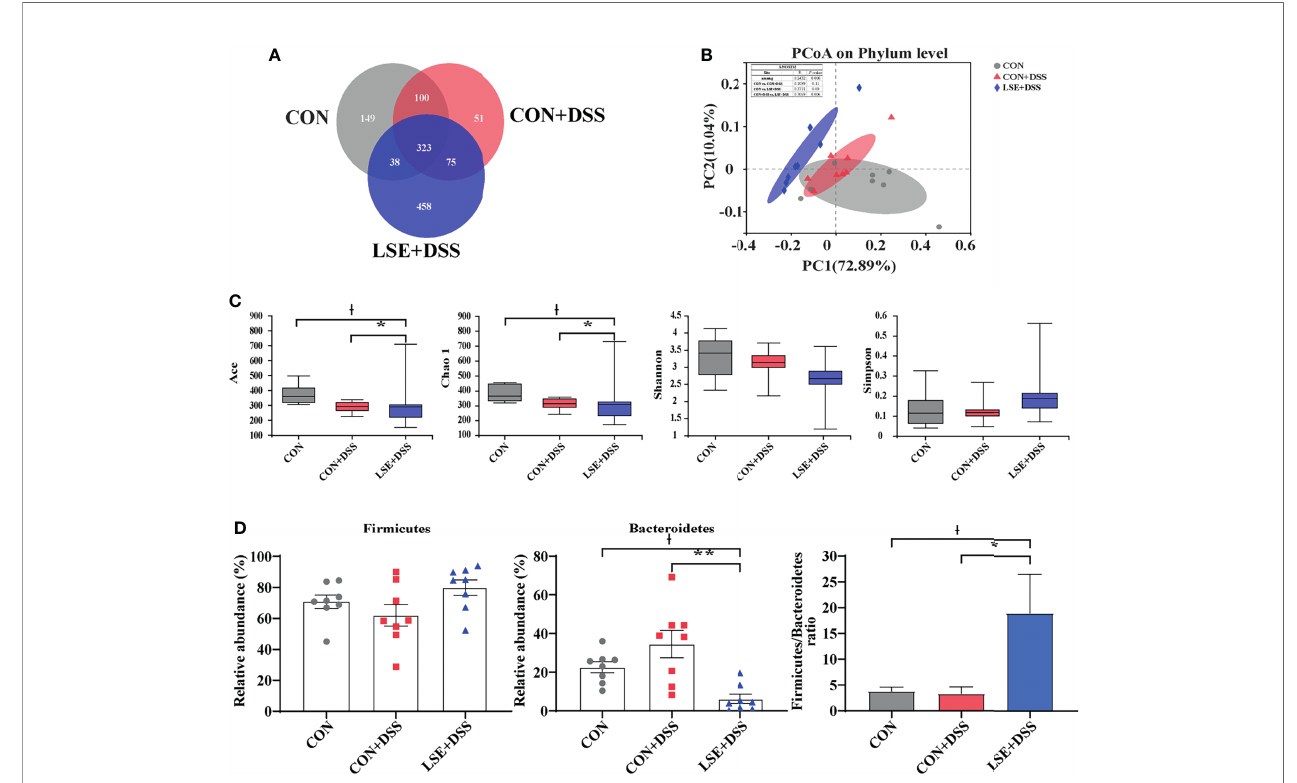
FIGURE 5 | Effects of LSE administration on intestinal microbiota in fl ammatory in DSS-induced colitis mice. (A) A Venn diagram showing the overlap of the OTUs identi fi ed in the intestinal microbiota among the three groups. (B) PCoA plot of the gut microbiota based on weighted UniFrac distance. (C) The a -diversity of each group. (D) The abundance of Firmicutes and Bacteroidetes and Firmicutes / Bacteroidetes ratio at phylum levels. Data are presented as mean ± SEM, n = 8. * P < 0.05 and ** P < 0.01 vs. the CON+DSS group, † P < 0.05 vs. the CON